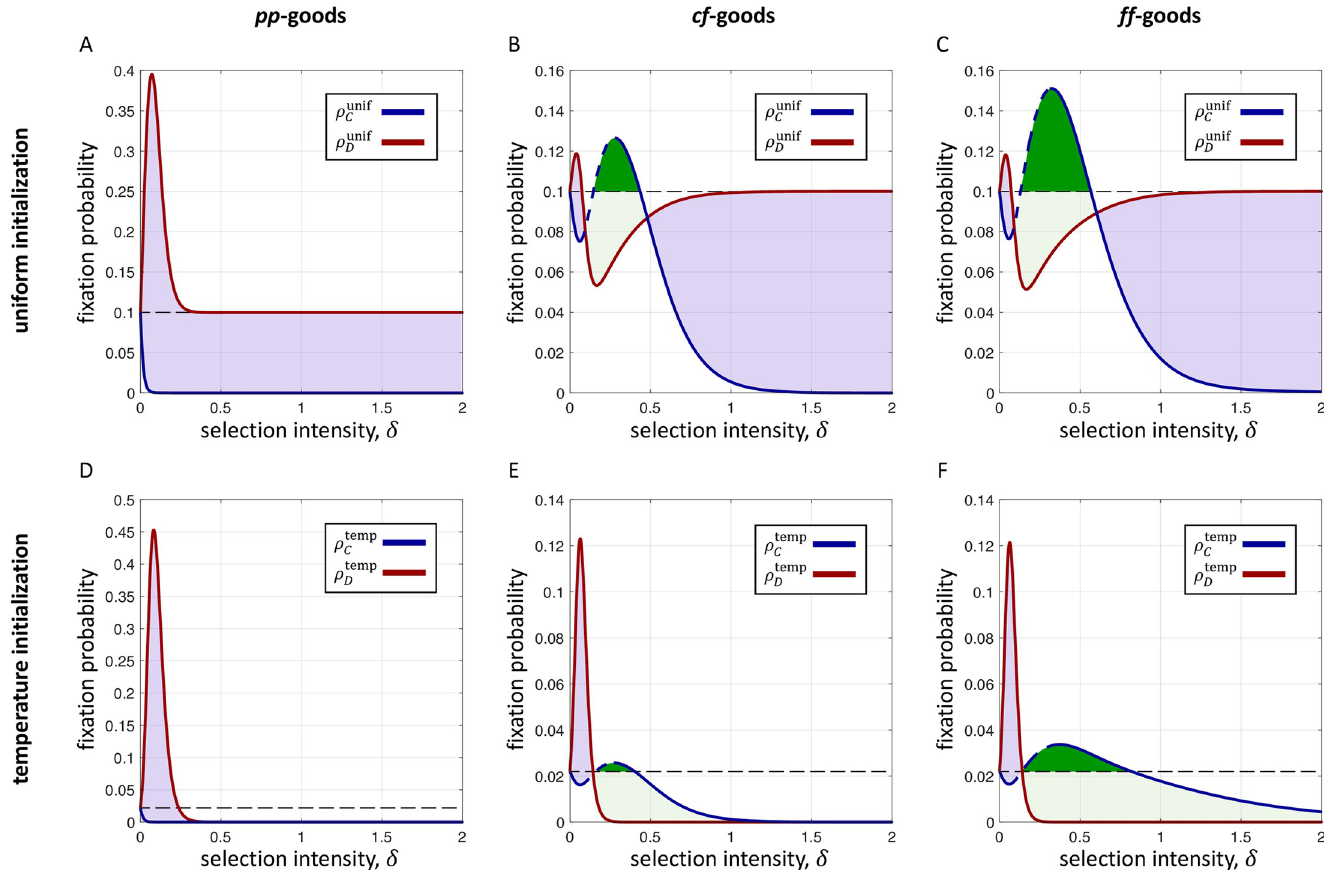
Fig 4. Fixation probabilities on the star of size N = 10 under Bd updating (exact calculations). A–C depict the dynamics of social goods under uniform initialization, whereas D–F show those of death-rate-based temperature initialization. In each panel, we see that weak selection disfavors producers, consistent with earlier studies. However, for both kinds of mutant initialization, we observe the remarkable fact that producers of cf - and ff -goods can be favored, both absolutely (dark green, condition ( A 0 ); blue dashed line, condition ( A 0 )) and relative to non-producers (dark+light green, condition ( R 0 )), for a range of intermediate selection intensities. This range represents a “sweet spot” for the population, wherein drift is strong enough to allow for configurations favorable to producers to get established, and selection is strong enough to push those favored configurations toward fixation. The purple regions represent selection intensities for which C is disfavored relative to D (condition ( R 0 )). Black dashed lines indicate fixation probabilities under neutral drift. For simplicity, we do not show condition ( R 0 ). Parameters: b = 5 and c = 1.